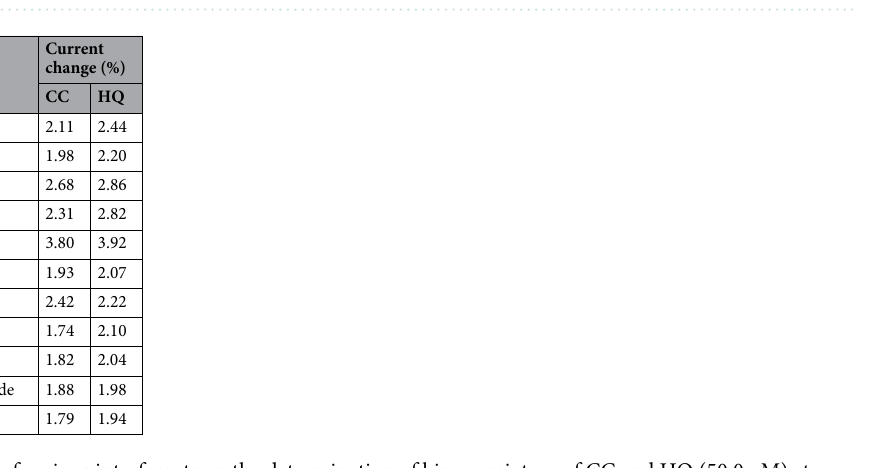
Table 5. Effect of various interferents on the determination of binary mixture of CC and HQ (50.0 μM) at polysorbate 80/CPE.